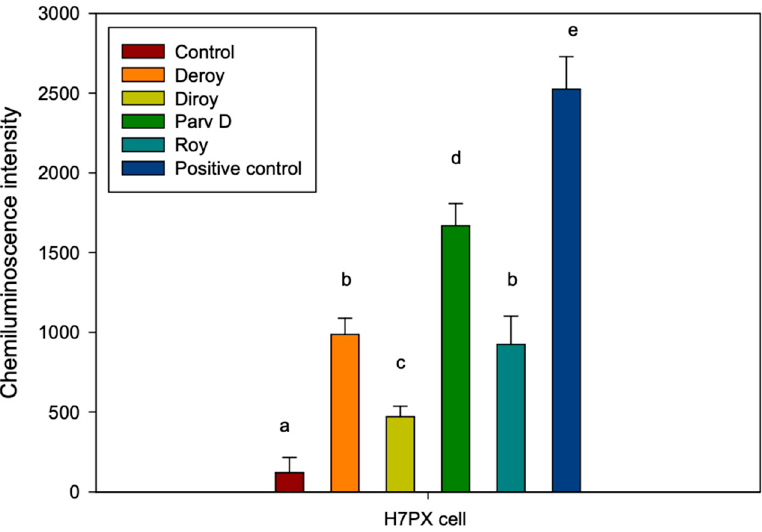
Figure 4. The levels of phosphorylated H2A.X identified in H7PX cell line treated with 6,7-dehydroroyleanone (Deroy), 7 β ,6 β -dihydroxyroyleanone (Diroy), 7 α -acetoxy-6 β -hydroxyroyleanone (Roy) and parvifloron D (Parv D), indicating the presence of DSBs. Cells were treated with all compounds for 24 h. The mean values ± SD of γ -X2A.X were calculated from three independent ELISA experiments. Different letters indicate significant differences at P < 0.05. Bleomycine was used as a positive control.